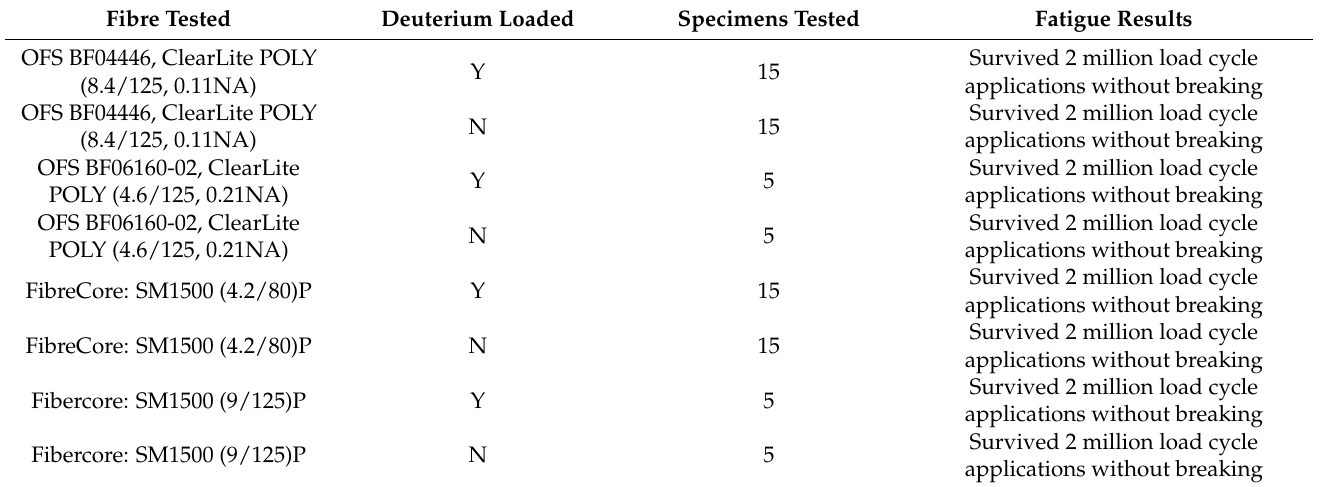
Table 3. Fatigue test results for the Type I trans-jacket